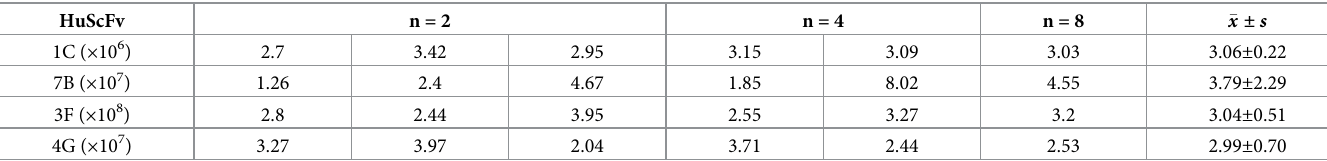
associated with existing treatment drugs for influenza virus are becoming increasingly appar- ent (Uyeki 2009), Consequently, there is an urgent need to develop remedies for influenza. While traditional small molecule drugs are not suitable for inhibiting the protein-protein interface (PPI), we developed a fully humanized small antibody fragment (human HuScFv) for the treatment of influenza [15, 16]. The HuScFv fragment is safe for use in different popula- tions because it is human in origin and does not cause additional inflammation. Typically, each specific antibody molecule binds to its target using several amino acid residues in the complementary determination region (CDR) and the immunoglobulin framework (FR) of the VH and VL domains. Antibody drugs have an advantage over traditional small-molecule drugs in terms of responding to viral mutations [17]. In recent years, humanized antibodies based on HA protein encoded by influenza virus fragment 4, non-structural protein NS1 Table 2. The affinity constants were measured as a Ka